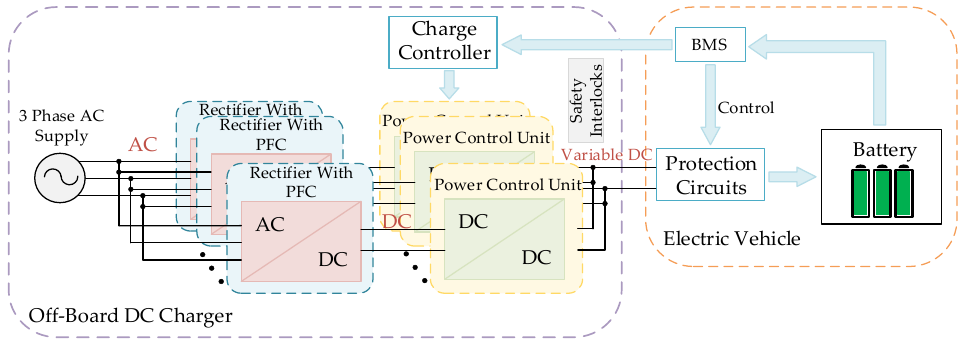
Figure 4. Block diagram of the con fi guration of the fast-charging system.